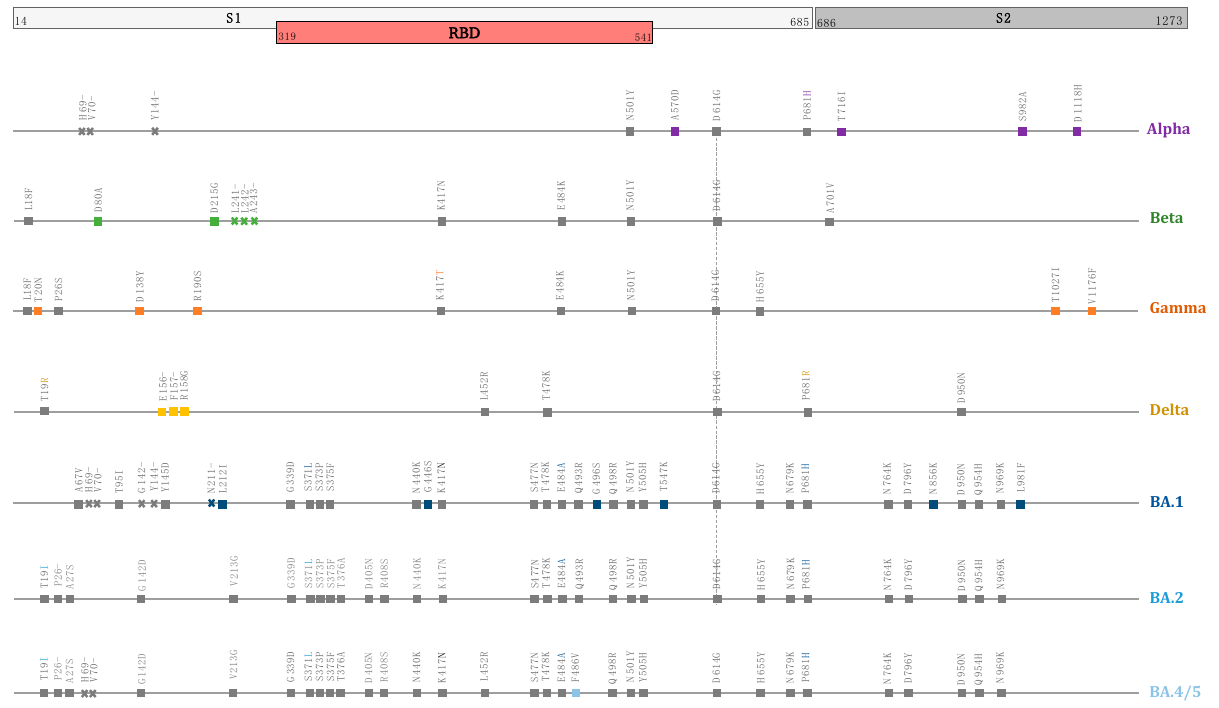
Figure 1. COVID-19 variants of concern (VOC), their origin, and characteristics. Arrows represent relative increase or decrease in the binding affinity to ACE2 receptor.